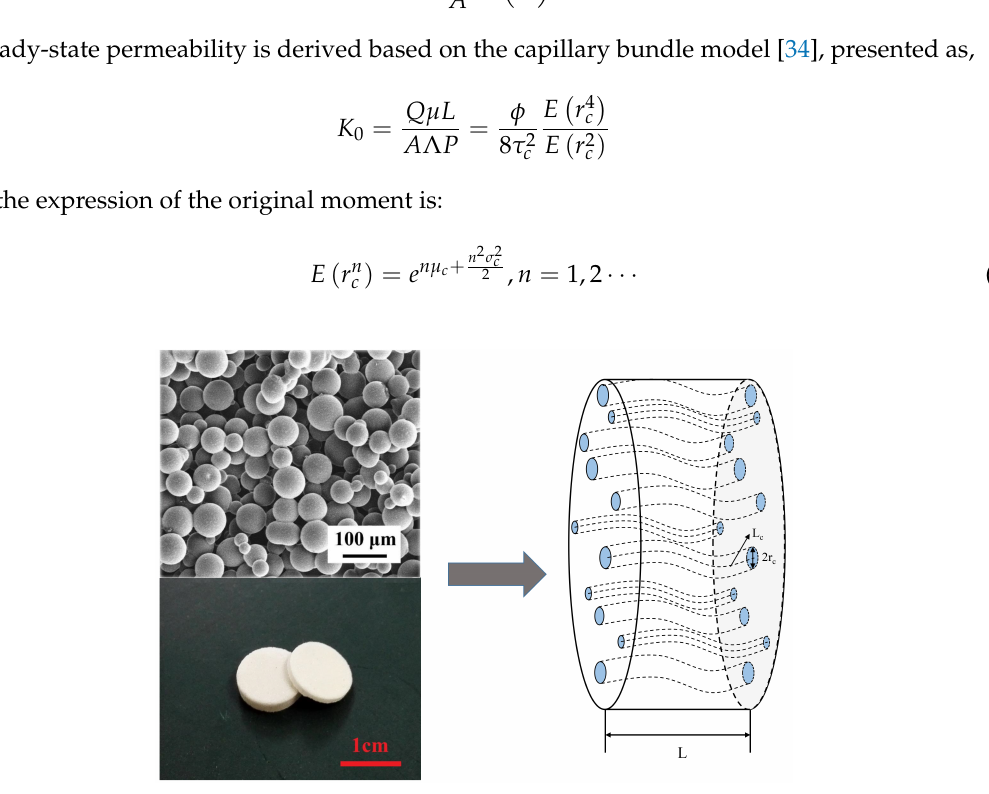
Figure 4. Porous transducers, their microstructure, and the equivalent capillary bundle